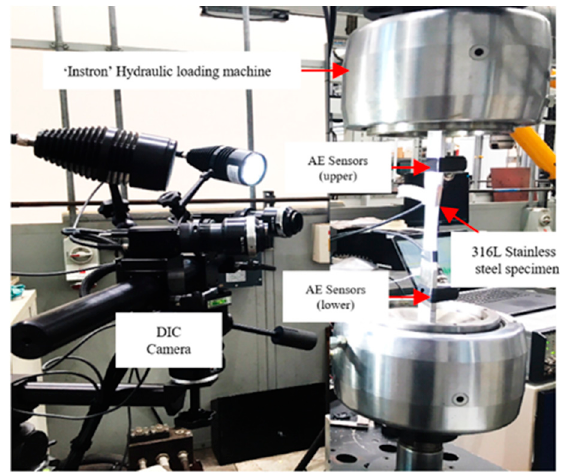
Figure 10. Experimental setup for the tensile test.